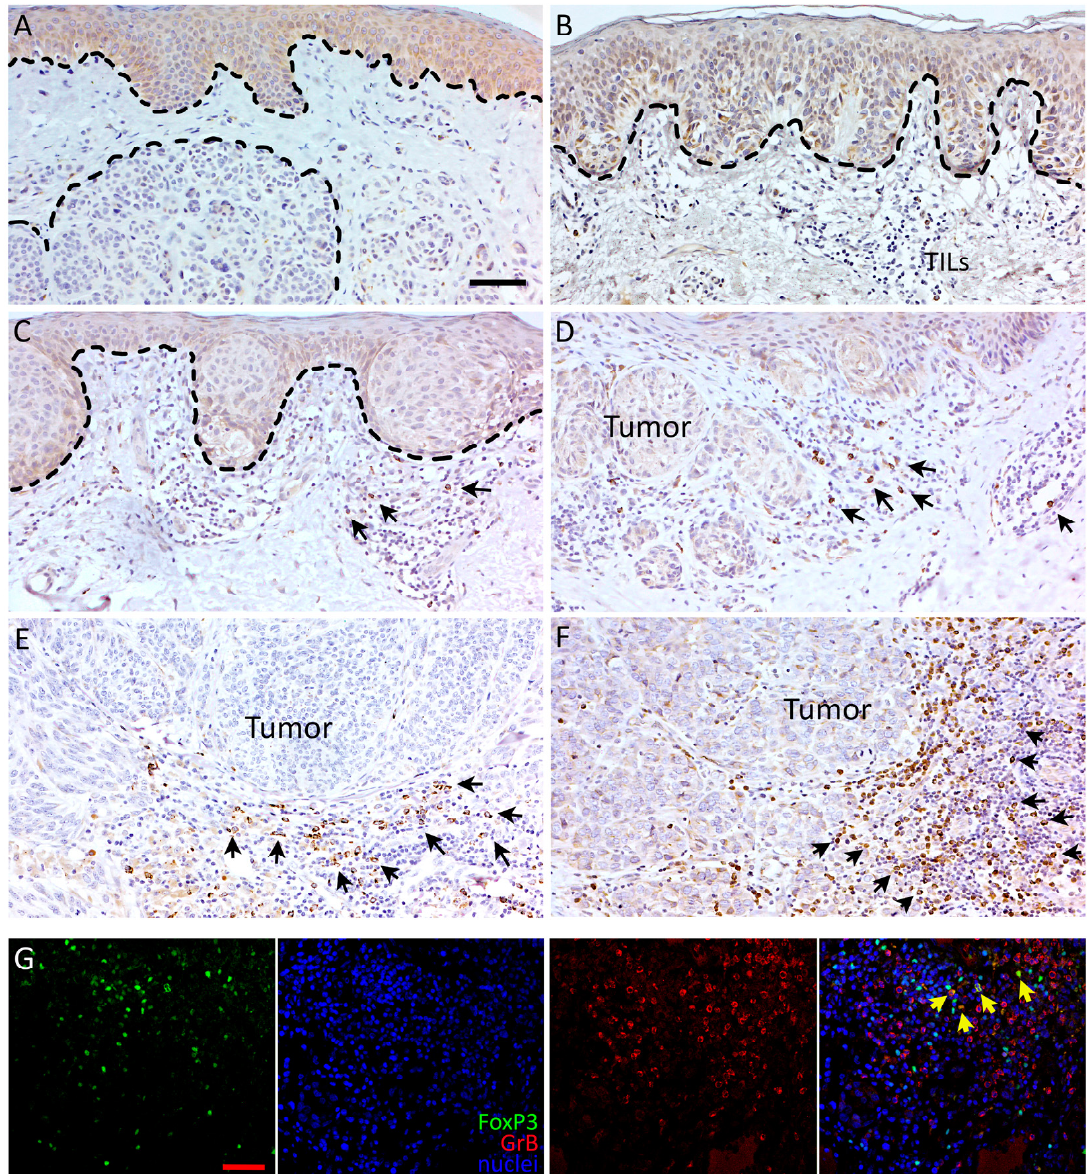
Figure 2. Representative immunohistochemical detection of GrB+ lymphocytes (positive staining shown in brown and counterstained nuclei in blue in A – F ). Immunohistochemical stainings of GrB in benign ( A ) and dysplastic nevi ( B ), in situ melanoma ( C ), superficial (Breslow’s depth < 1 mm, D ) and deep (Breslow’s depth > 4 mm, E ) melanomas and lymph node metastasis ( F ). The dashed line in A and B marks the epidermis in benign and dysplastic nevi, respectively, and intradermal nest of nevus cells in A . The dashed line in C defines the border between tumor and stroma in in situ melanoma. The arrows in C – F point to the stromal GrB+ cells. Scale bar is 50 µm in A applies for A – F (×200 magnification). Immunofluorescence double staining of GrB and FoxP3 in pT4 melanoma ( G ) indicates that GrB+ cells localize in the same region as FoxP3+ Tregs in the tumor–stroma interface but no clear colocalization is observed (arrows). Scale bar 50 µm (×100 magnification). TILS = tumor-infiltrating lymphocytes.